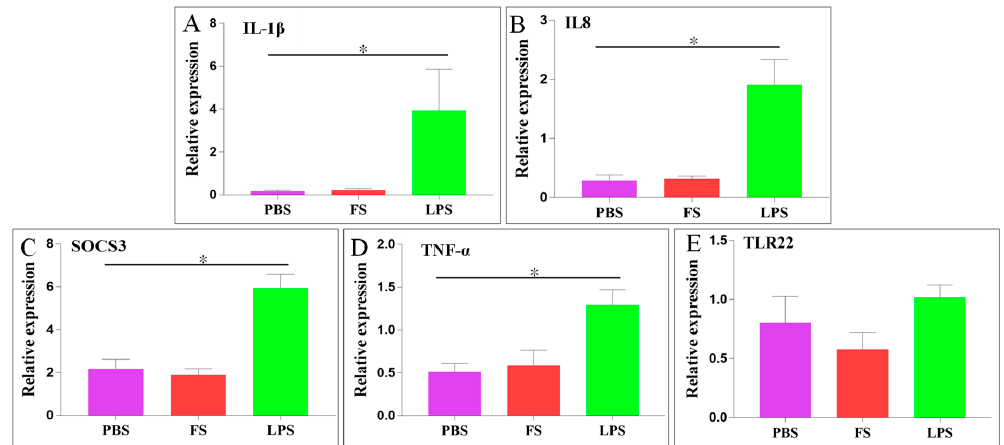
Figure 8. Differential expression of immune-related genes in the liver after FS or LPS injection. ( A